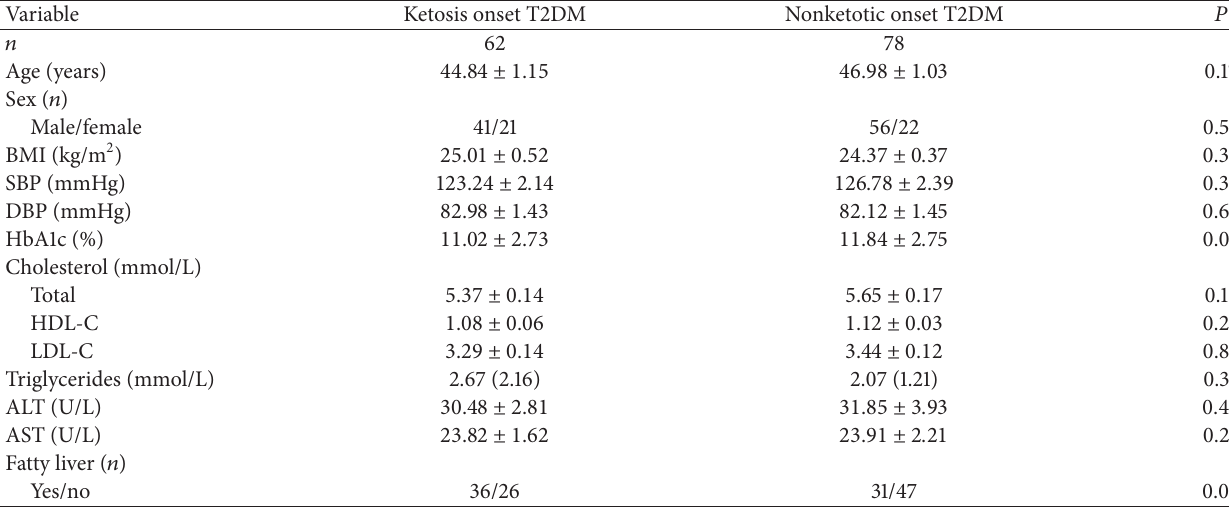
Table 1: Clinical and biochemical parameters of